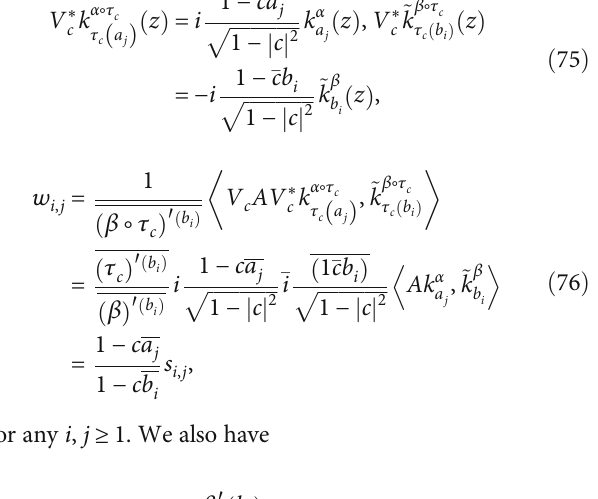
p Ak ffiffiffiffiffiffiffiffiffiffiffiffiffiffi 1 − c j j 2